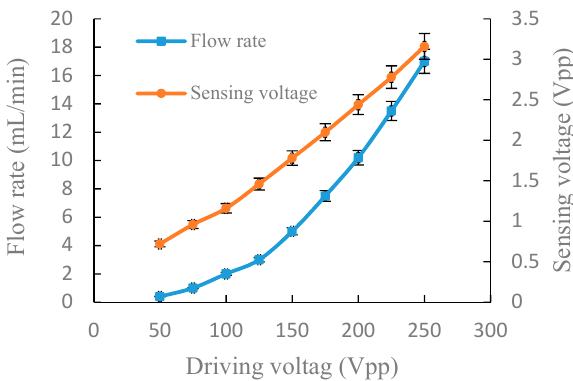
Figure 7. Output flow rate and sensing voltage under a fixed frequency of 100 Hz in serial connection.